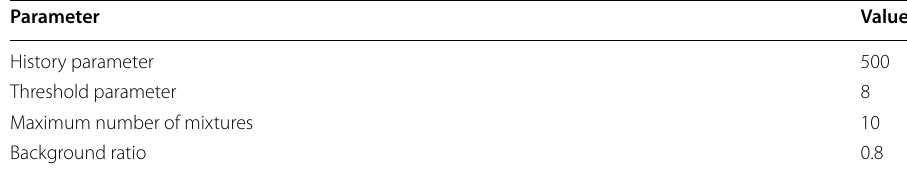
Table 1 Parameter values used in Gaussian mixture model based background subtraction